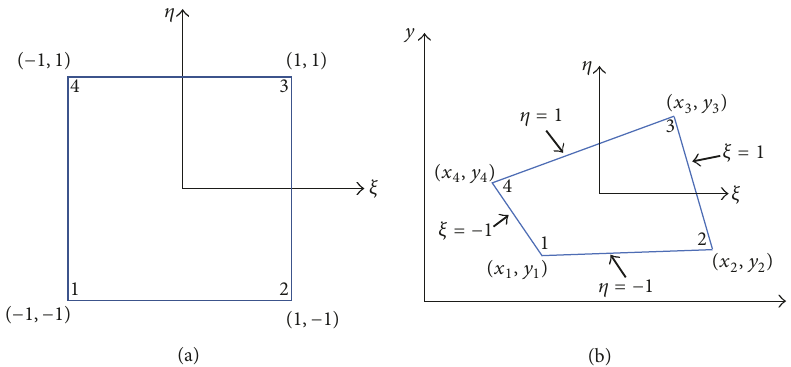
Figure 1: Natural coordinate system (a) is used to map arbitrary shapes from element coordinate system (b) on a 2 by 2